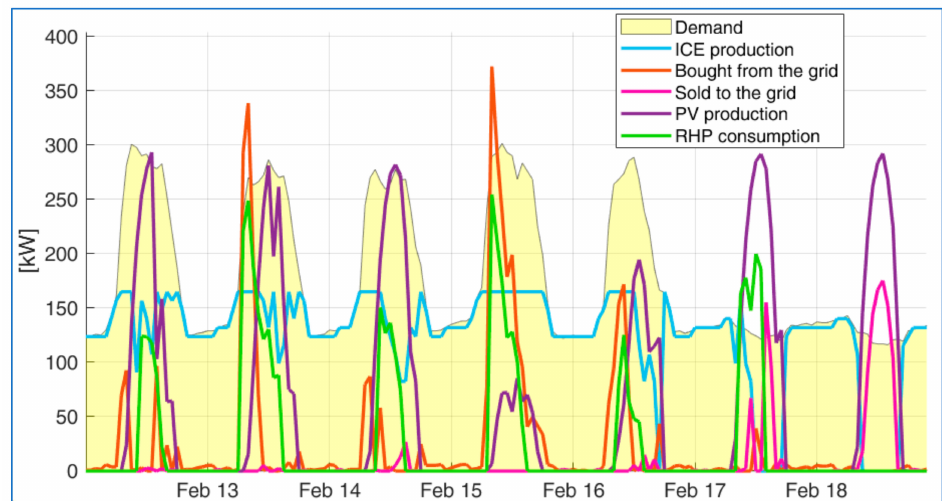
Figure 8. Optimal operation: electricity flows in a typical winter week.